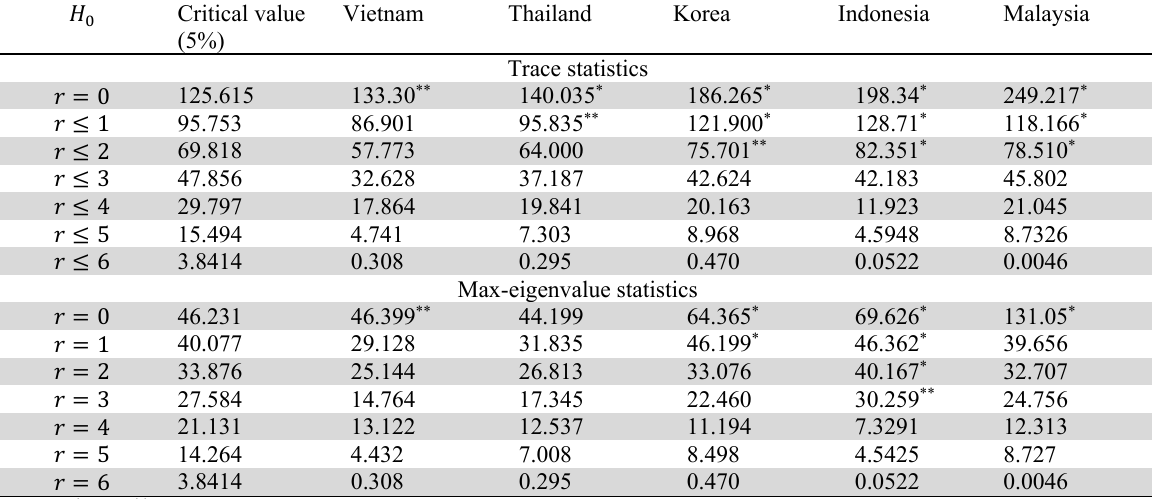
Cointegration tests